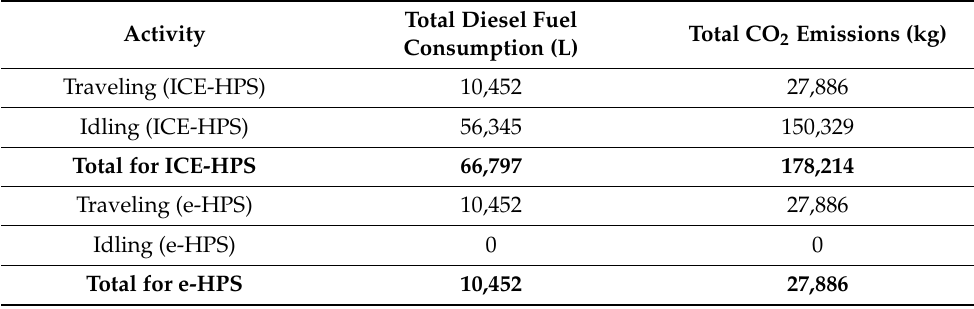
Table 4. Diesel fuel consumption and CO 2 emissions during the vehicle